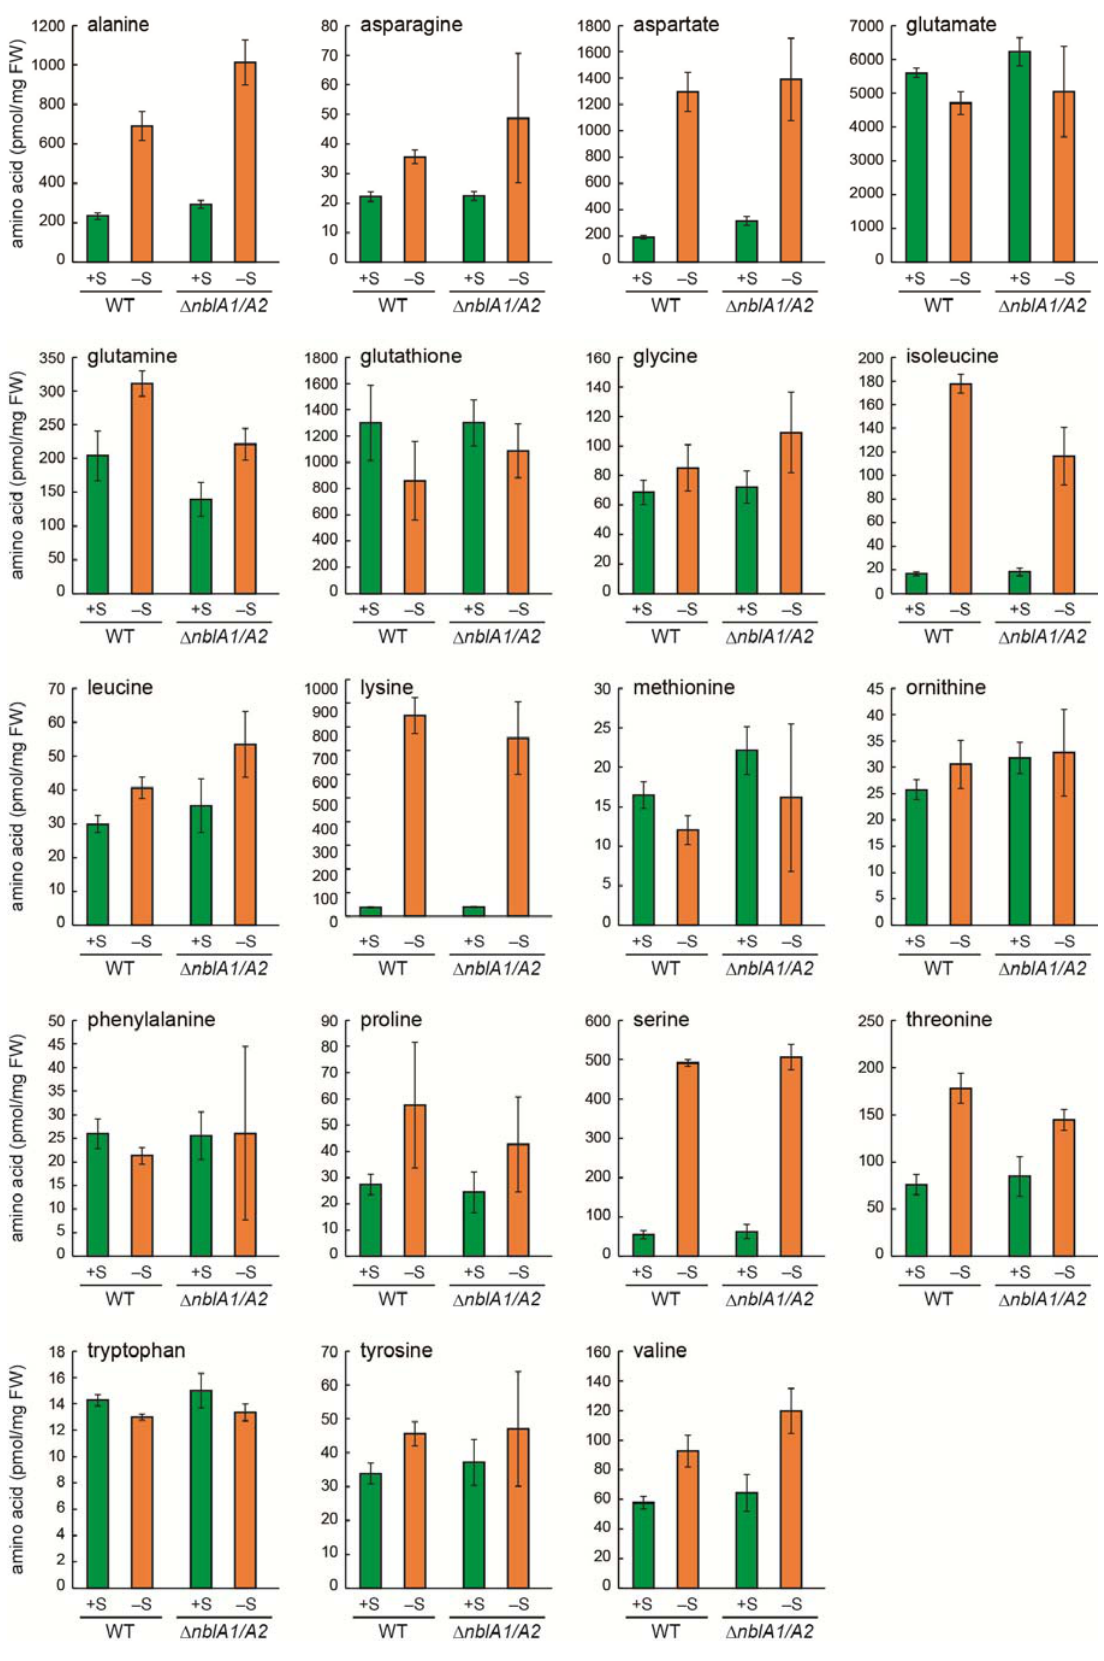
Figure 7. Amino acid pools in WT Synechocystis and the nblA1/A2 mutant ( ∆ nblA1/A2 ) after 24 h in sulfur-sufficient (+S) or sulfur-deficient (–S) medium. Standard deviation is shown from three independent